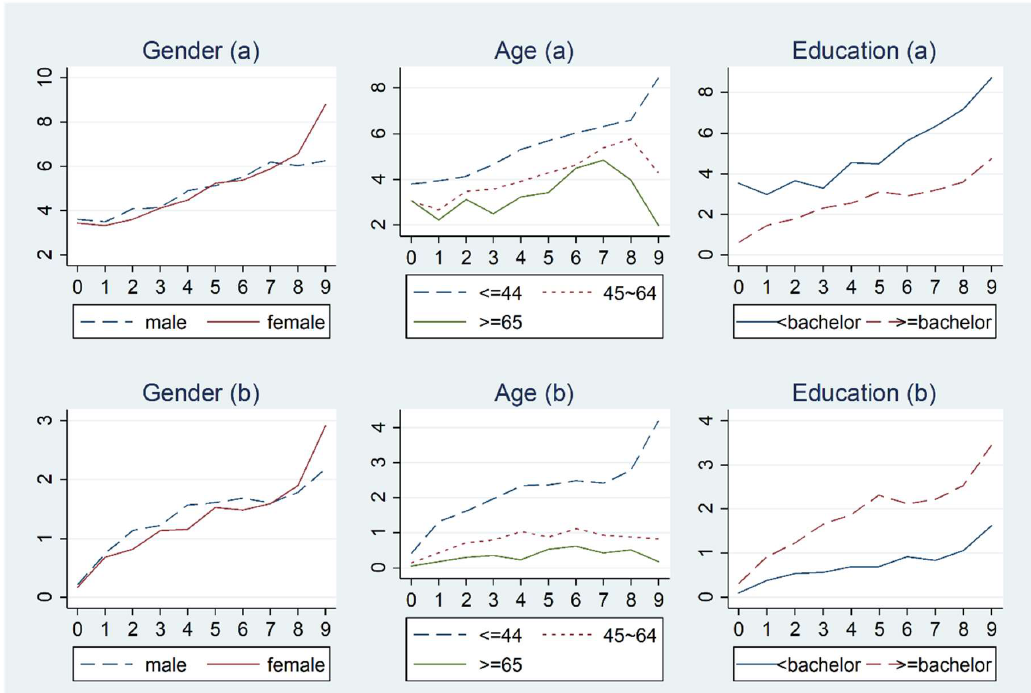
Figure 3. Relationship between ridesharing and public transit use varying by gender, age, and education level for those who use ridesharing in the past 30 days: (a) 1–99 times; (b) 0–99 times. (for X-axis, 0 = 0 times, 1 = once, 2 = twice, 3 = 3 times, 4 = 4 times, 5 = 5 times, 6 = 6–10 times, 7 = 11–20 times, 8 = 21–30 times, and 9 = 31–99 times; the same for X-axis in Figures 4–7).